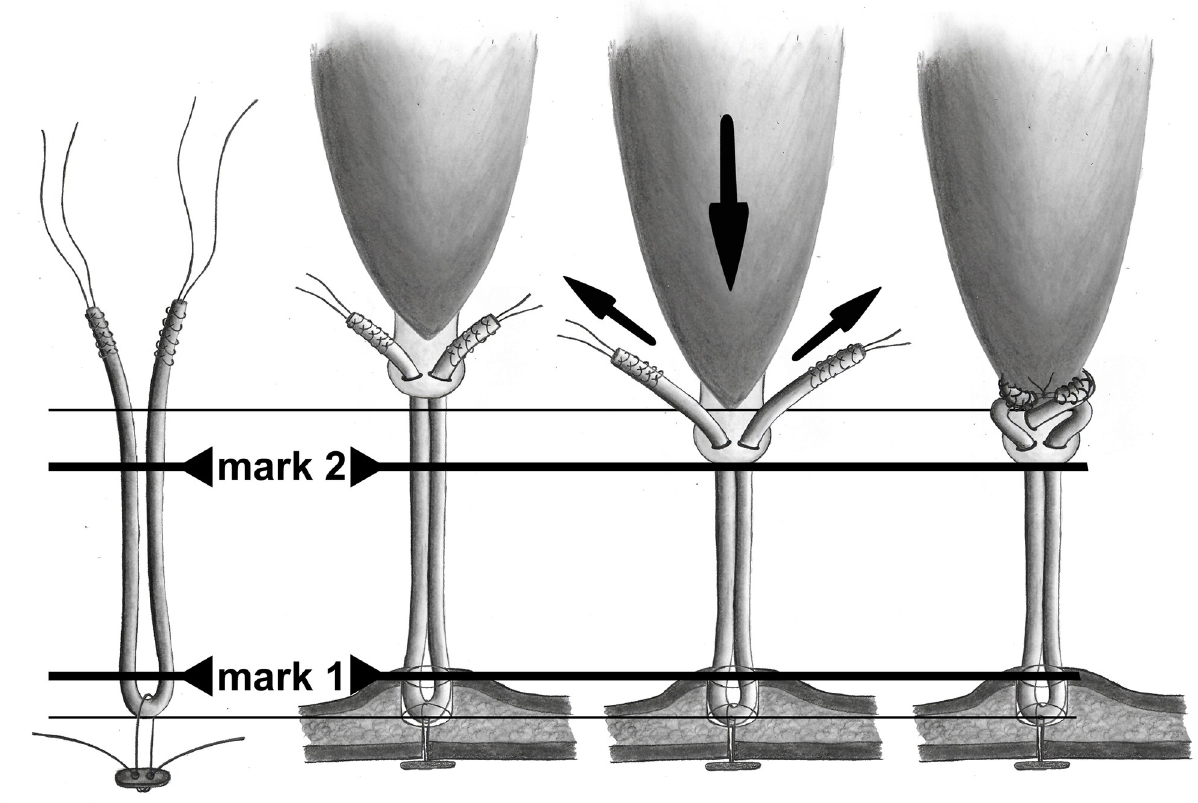
Fig 7. Surgical technique for distal biceps tendon auto-/allograft length adjustment. a) Tendon graft: Both graft ends are reinfored by #2 FiberWire. The bone tunnel length (mark 1) and calculated tendon length without the remaining tendon stump (mark 2) are marked on the graft. b) Tendon graft fixation distally: The tendon graft is first fixed distally and shuttled through the biceps tunnel. After that, the sutures are penetrated throught the remaining tendon with a sharp suture grasper clamp. c) Tendon length adjustment: The elbow is flexed as far as needed and the graft tensionned, until the marker is flash with the remaining tendon end. A slide back of the tendon is preventionned by some sutures (#2 Vicryl). d) Tendon graft fixation proximally: The graft is interwaved through the remaining tendon–two to three times, depending on graft length–and finally knotted together. Further sutures (#2 Vicryl) are performed.